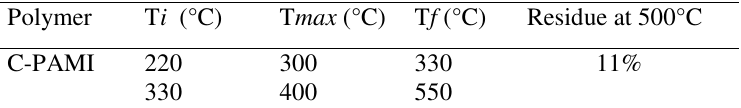
Table 7 . Percentage weight loss of copolymer at various temperatures from the